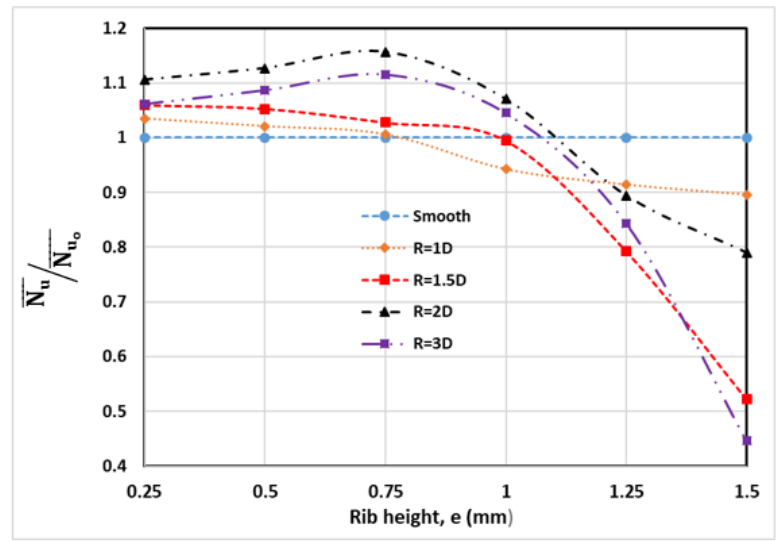
Figure 15. Effect of rib height on normalized average N (cid:2931) for all rib locations, R e = 20,000.